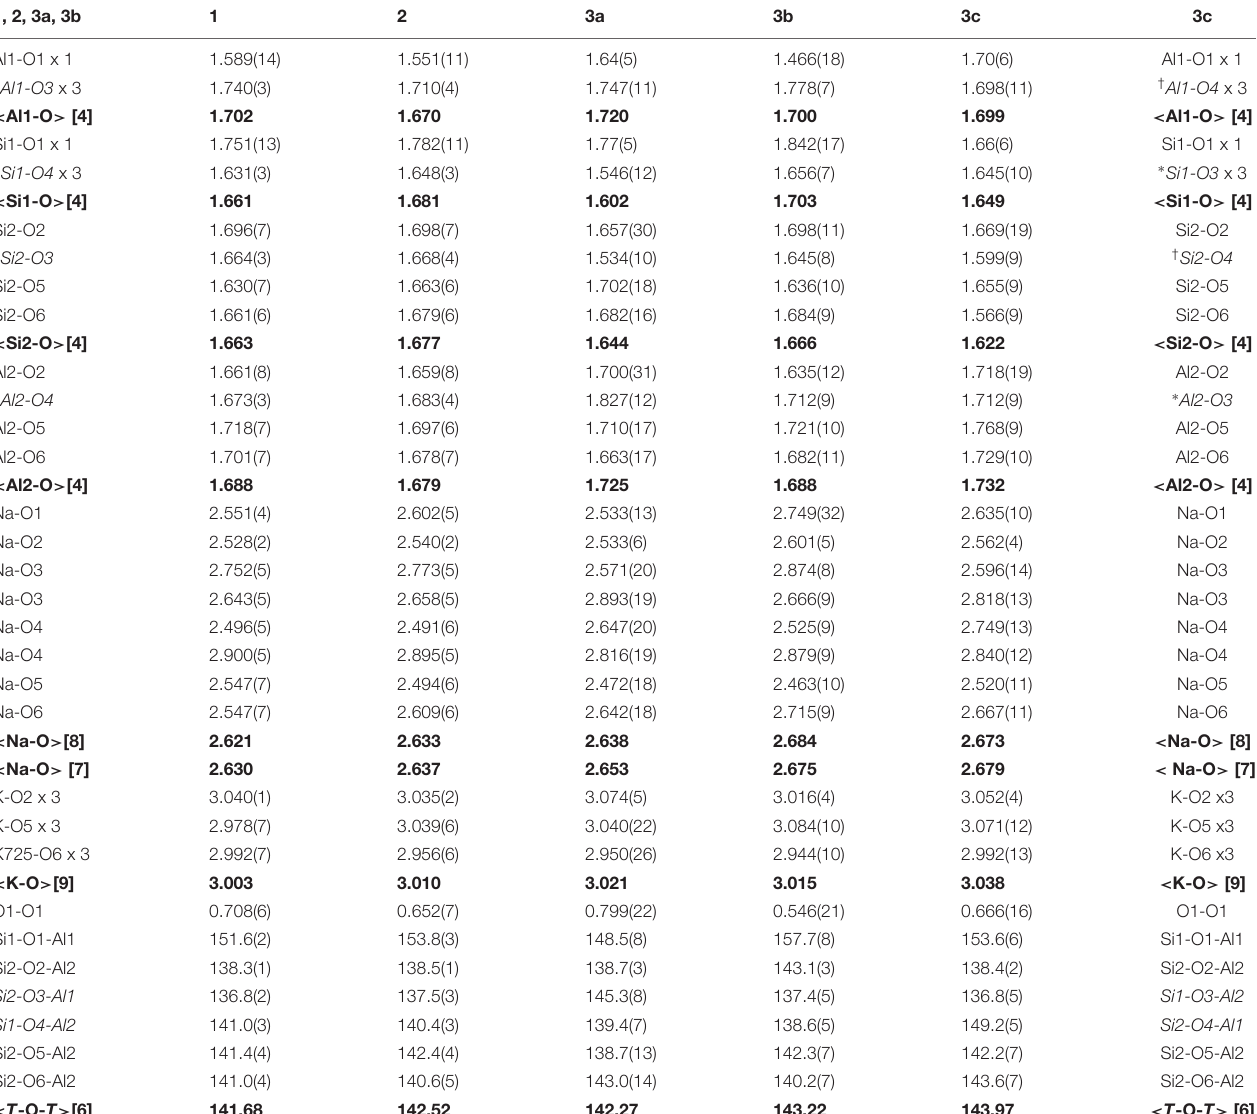
TABLE 4 | Bond distances [Å] and angles [ ◦ ] in three nepheline